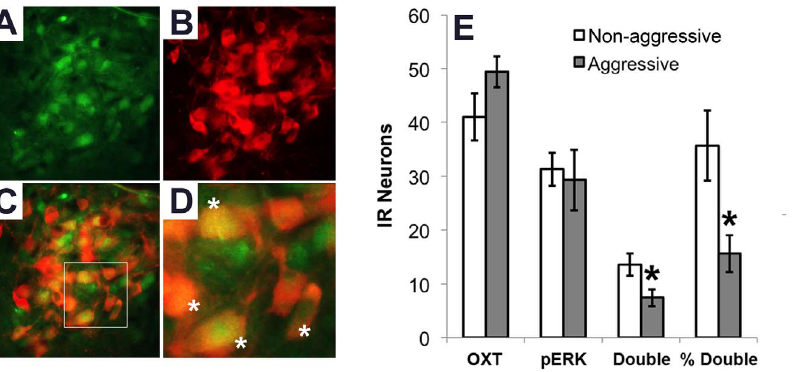
Figure 6. Immunohistochemical double-labeling of OXT and pERK. A–C: Illustrations of OXT (green) and pERK (red) IF in the PVNlm of a non- aggressive female. Total area of A, B and C corresponds to the size of the analyzed area; D: Higher magnification of the white square in C, white asterisks signify double-labeled neurons; E: Density of single- and double-labeled neurons as well as the percentage of OXT-IR neurons that also showed pERK-IR in non-aggressive (white bars, n=7) and aggressive (grey bars, n=7) adolescent female NAB rats. Data are means 6 s.e.m; *P ,